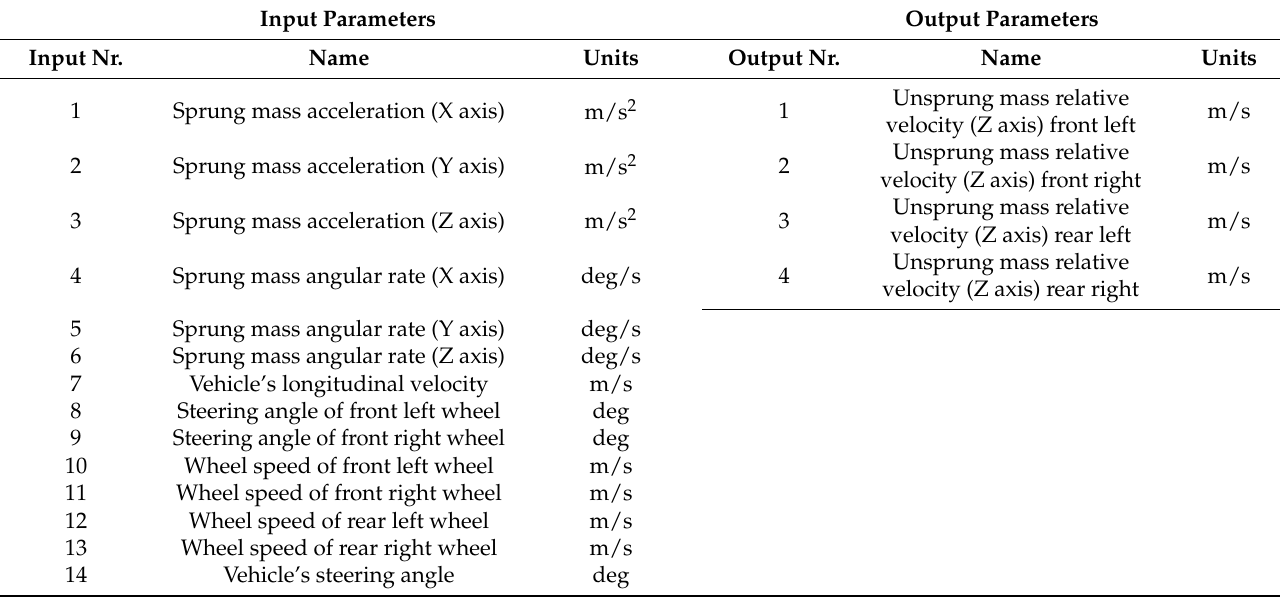
Table 2. Input and output sensor data used for training NN model.